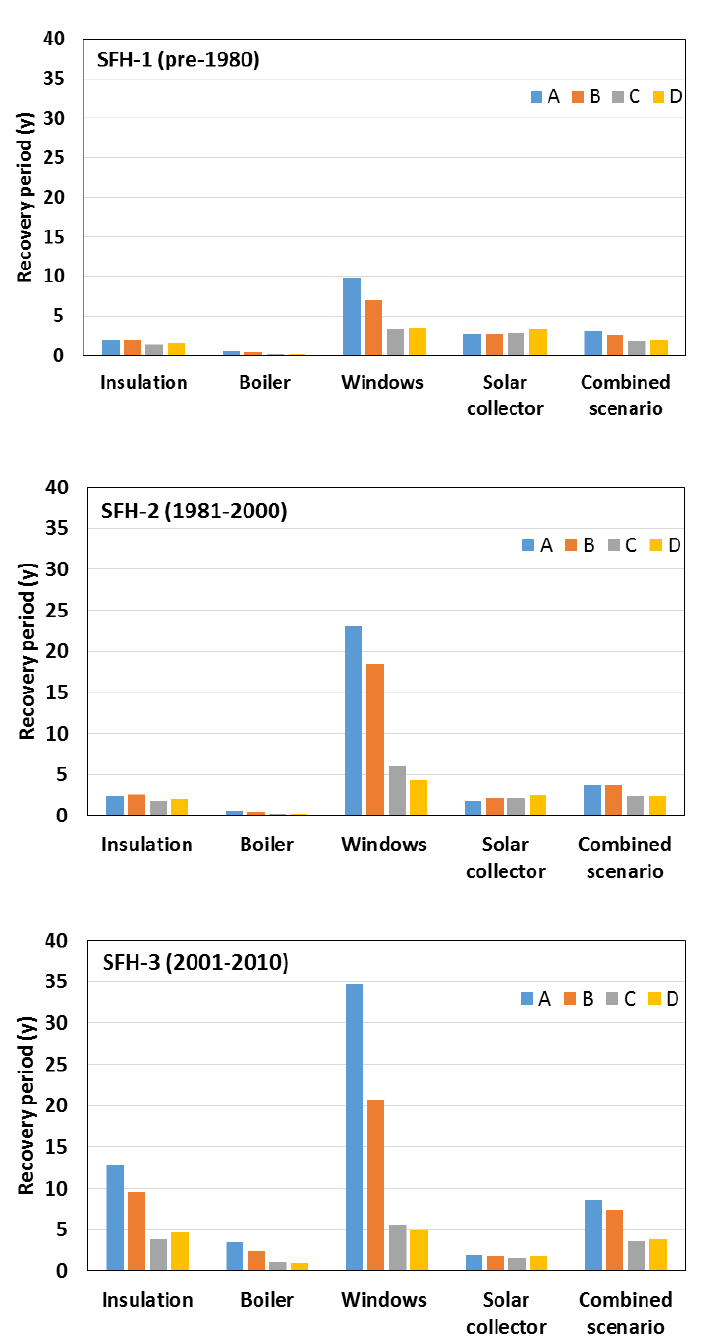
Figure 6. Energy recovery time (years) for individual energy conservation and efficiency measures and a combined scenario for the different SFH case studies in the four climate zones.